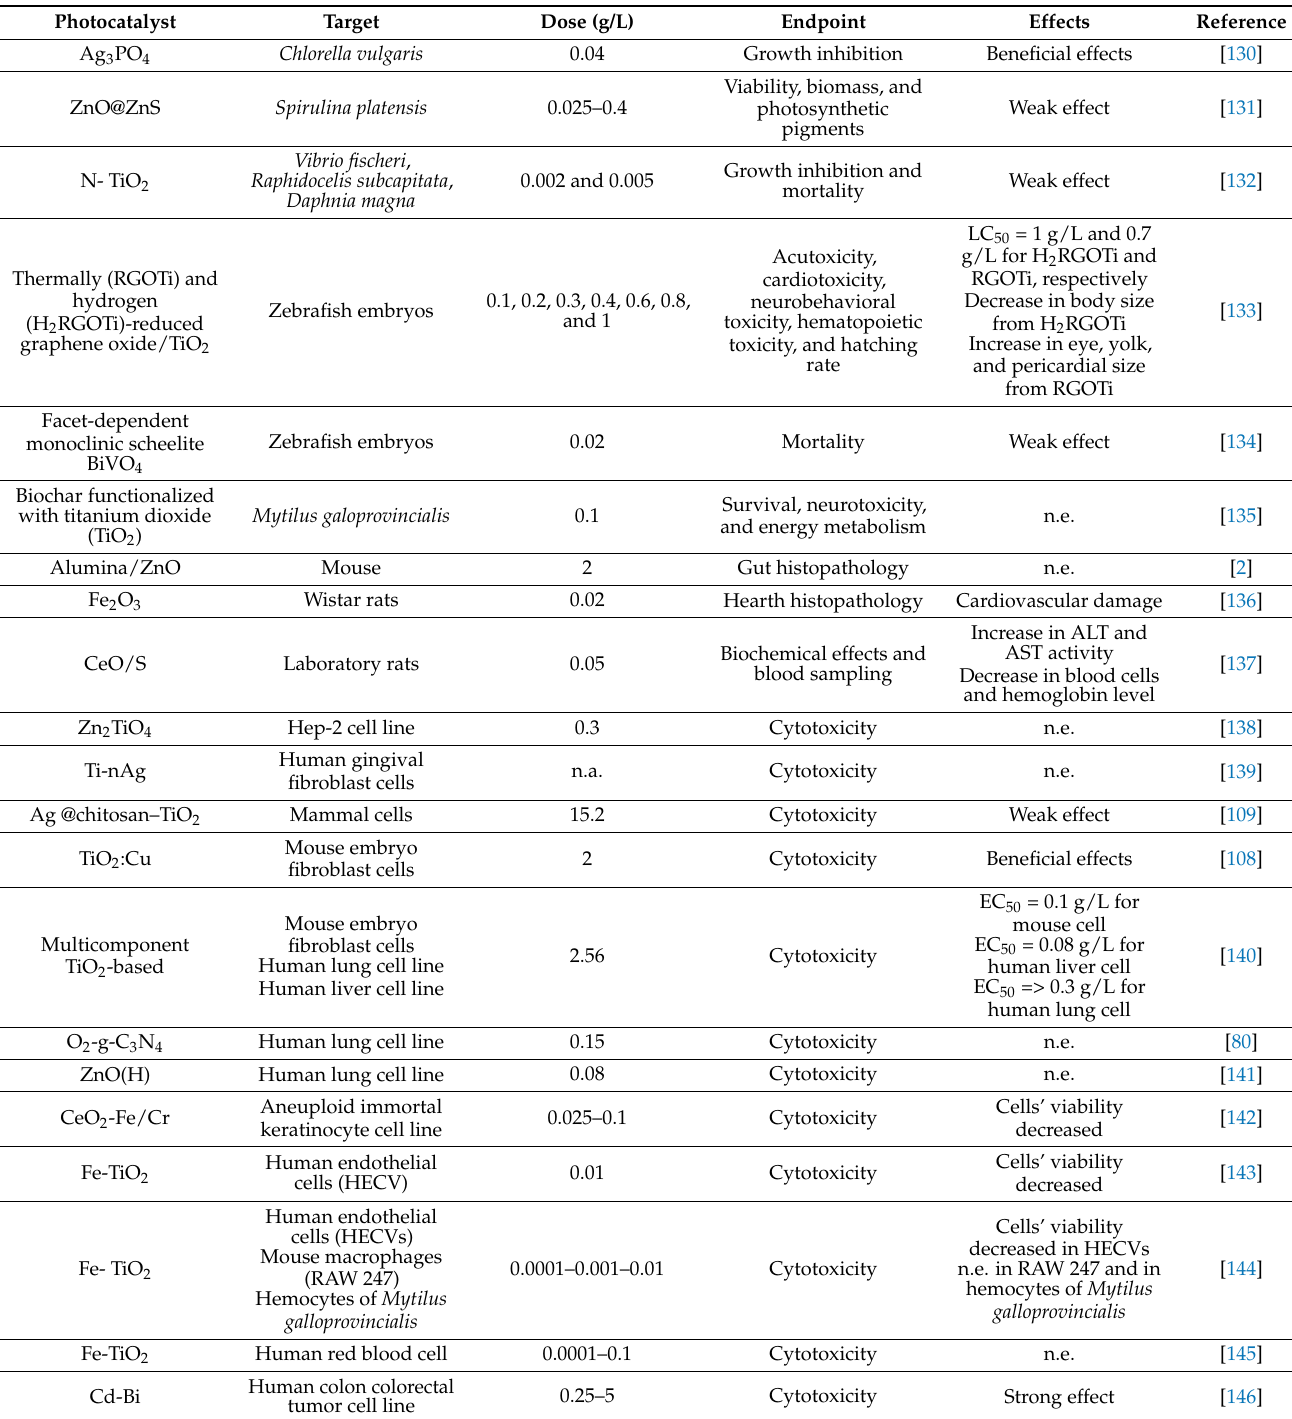
Table 4. Types of photocatalysts, targets, doses, endpoints, and